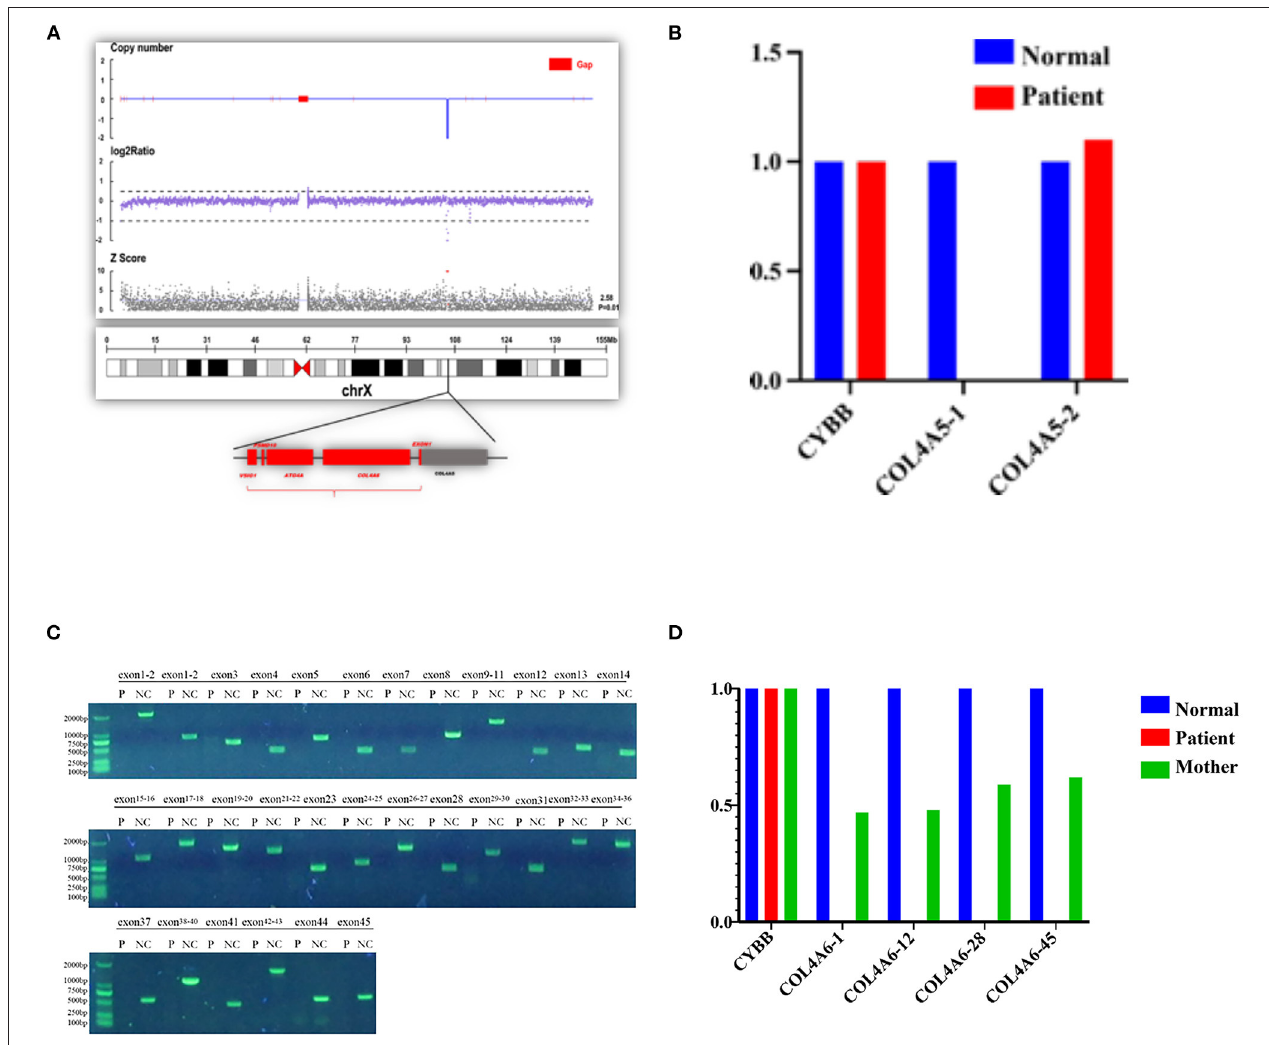
FIGURE 5 | Contiguous gene deletion of COL4A5 and COL4A6 in the AS case we reported. (A) Whole exon sequencing showed that the COL4A5 - COL4A6 gene was contiguously deleted on the X chromosome of the proband. (B) qPCR verification of the exon deletion break point of COL4A5 gene of the proband. The first exon of the COL4A5 gene was deleted, and the copy of the second exon was normal. (C) Verification of the exon deletion break point of COL4A6 gene of the proband. Amplifying each exon for the electrophoresis result of PCR in the same group of the normal control sample and the proband sample of the COL4A6 gene. The fragment size is 1,986 bp, 643 bp, 1,560 bp, 376 bp, 714 bp, 1,354 bp, 568 bp, 796 bp, 1,402 bp, 383 bp, 509 bp, 466 bp, 1,078 bp, 1,776 bp, 1,473 bp, 1,278 bp, and 611 bp. The amplification results of control genes of the proband and normal control samples have obvious specific bands, and the product length is consistent with the design length. It is suggested that the proband COL4A6 gene may be homozygous deletion. (D) qPCR verification of the exon deletion break point of COL4A6 gene of the proband and mother of the proband. The normal control samples, proband samples, and maternal samples were detected by fluorescence quantitative PCR in the same group, and the copy numbers of exons 1, 12, 28, and 45 (represented by COL4A6 -1, COL4A6 -12, COL4A6 -28, and COL4A6 -45, respectively) of the target gene were detected by using ALB gene as internal reference gene. The results showed that the COL4A6 gene of the proband had no amplification signal. That is, no copy of the gene was detected. The ratio of the copy number of each exon of the COL4A6 gene in the maternal sample to the normal control is about 0.5, suggesting that the proband has a homozygous deletion of the COL4A6 gene and the maternal sample has heterozygous